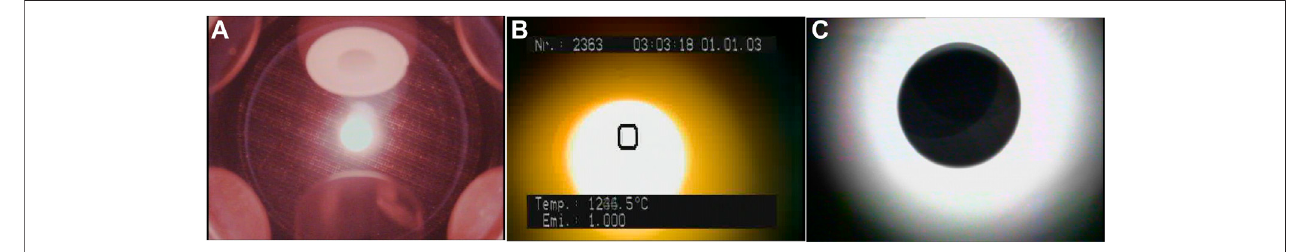
FIGURE 1 | Images of a molten Al 2 O 3 sample levitated in the ISS-ELF: (A) Overview with surrounding 6 electrodes; (B) Image taken by a built-in camera in the pyrometer; (C) A magni fi ed image of a UV backlit